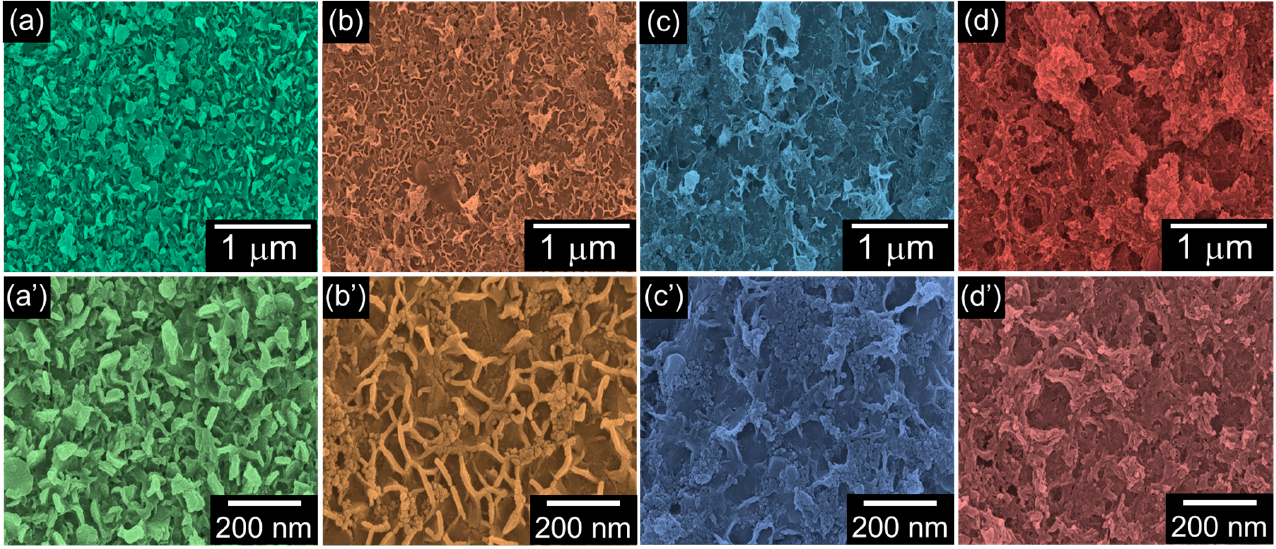
Figure 2. FE-SEM images of the ( a , a’ ) nHAP/CS, ( b , b’ ) Eu-nHAP/CS, ( c , c’ ) Y-nHAP/CS, and ( d , d’ ) Eu,Y-nHAP/CS composites. The upper and the lower panels are the low- and high-magnification images, respectively.